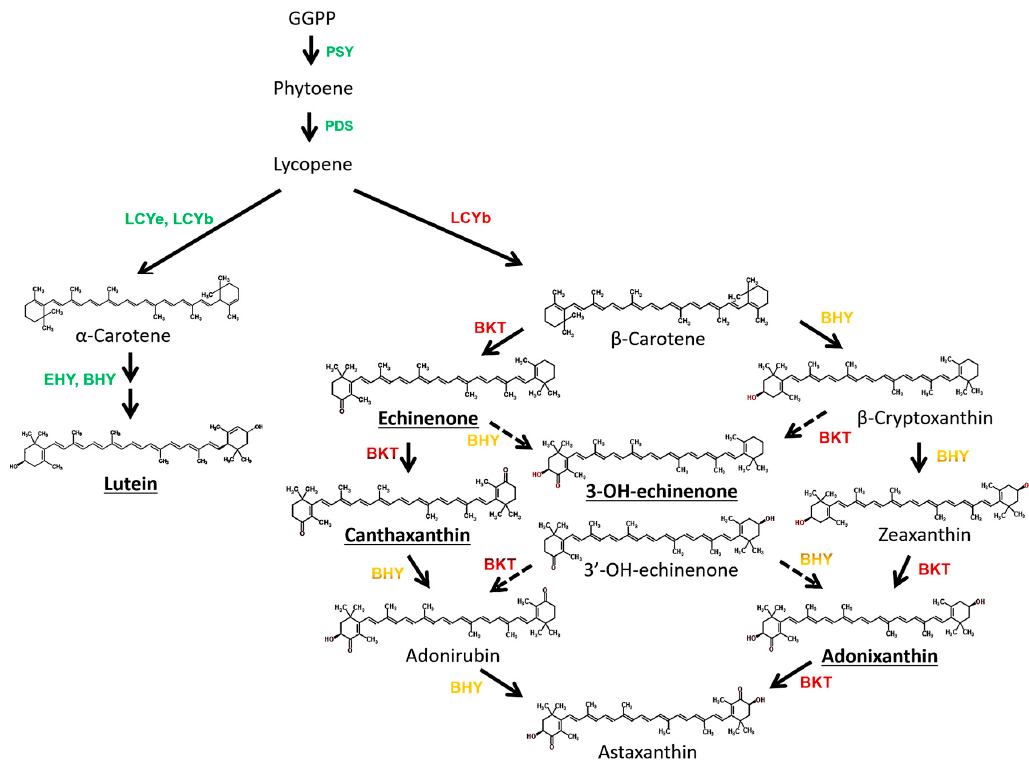
Figure 6. Possible carotenoid biosynthesis pathway in Chlorosarcinopsis PY02. Ketocarotenoids in bold and underlined were detected in this study. The carotenogenic enzymes involved in various reactions are indicated. The enzymes written in green signify the pathway in green cells whereas those written in red and yellow involve ketocarotenoid biosynthesis pathway under stress conditions. PSY: phytoene synthase; PDS: phytoene desaturase; LCYe: lycopene ε -cyclase; LCYb: lycopene β -cyclase; EHY: ε